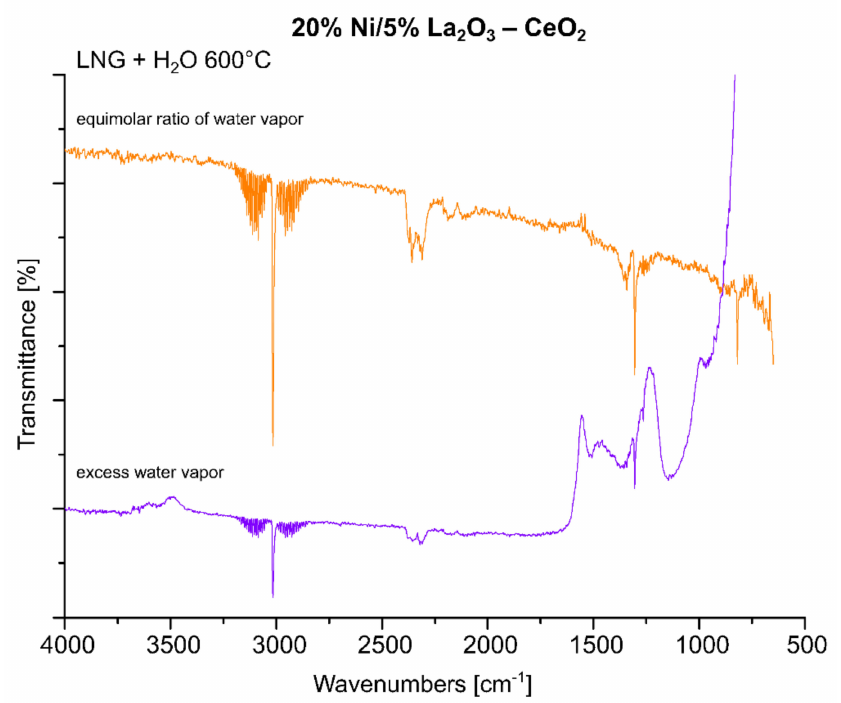
Figure 10. In situ IR spectra under steam reforming of LNG conditions at 600 ◦ C with equimolar and excess water vapor recorded for the 20% Ni/5% La 2 O 3 –CeO 2 catalyst.